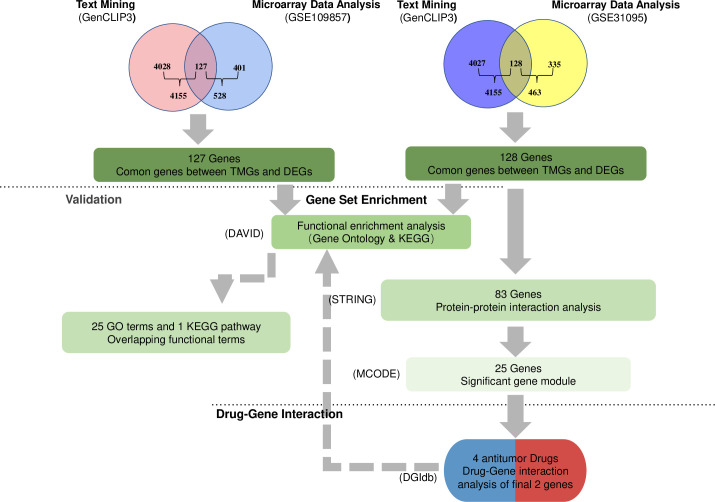
The framework of data analyses.